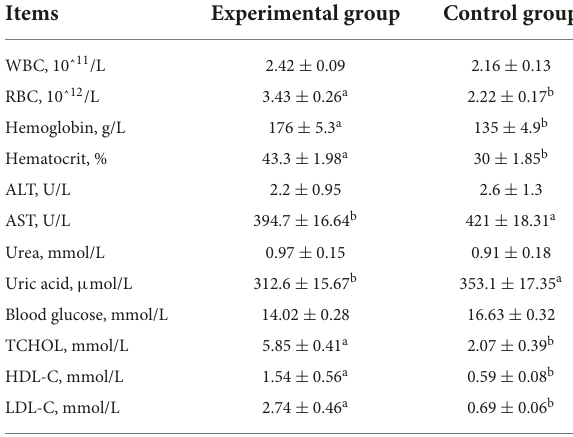
TABLE 8 Effect of MEFC on blood routine and biochemical indexes of laying